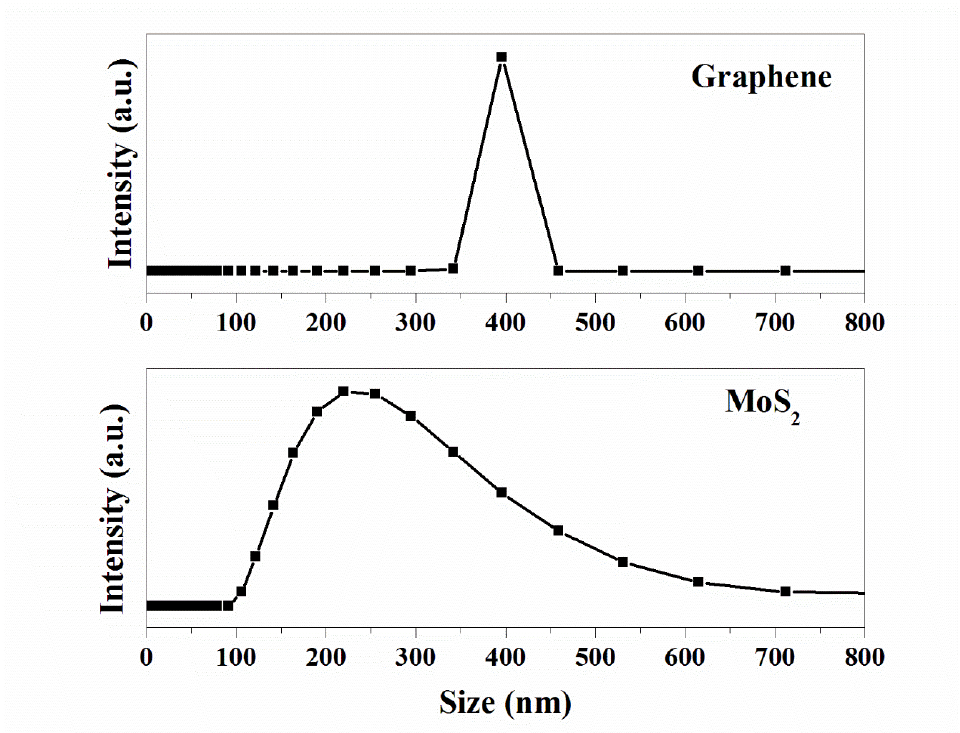
Figure 3. Average size distribution of the MoS 2 nanosheets and